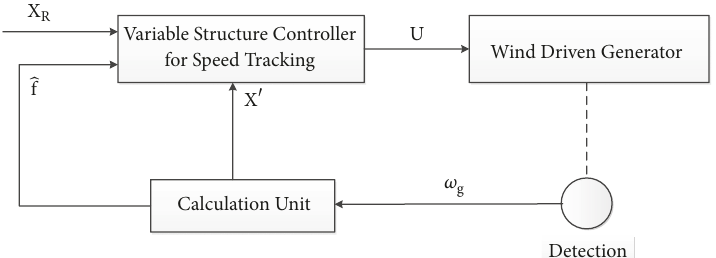
Figure 2: Control diagram of wind driven